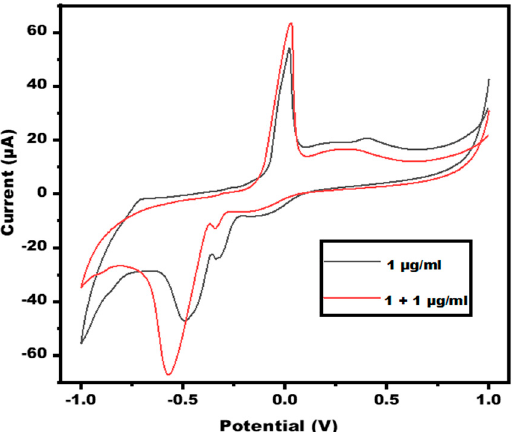
Figure 7. CV graph depicting the recovery value of Bilirubin/Enzyme/Ag-NPs Paper based sensor in 10 mM ferro-ferri in 0.1 M PBS at 50 mVs − 1 in the potential range from − 1 V to +1 V.